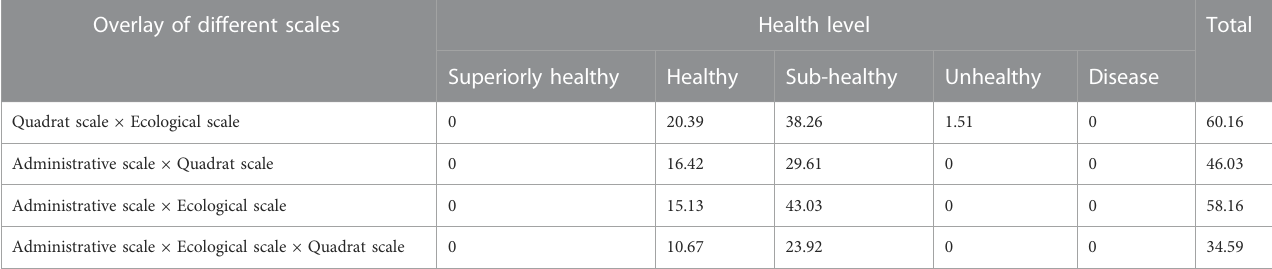
TABLE 8 Proportion of overlay area of ecosystem health at different scales (%). Overlay of different